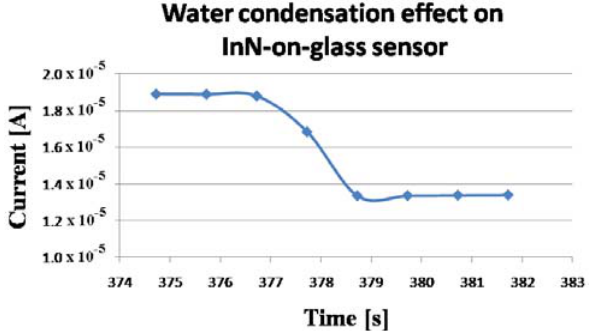
Figure 9. Current decrease during water condensation for the InN-on-glass condensation sensor. This corresponds to region a in Figure 8.